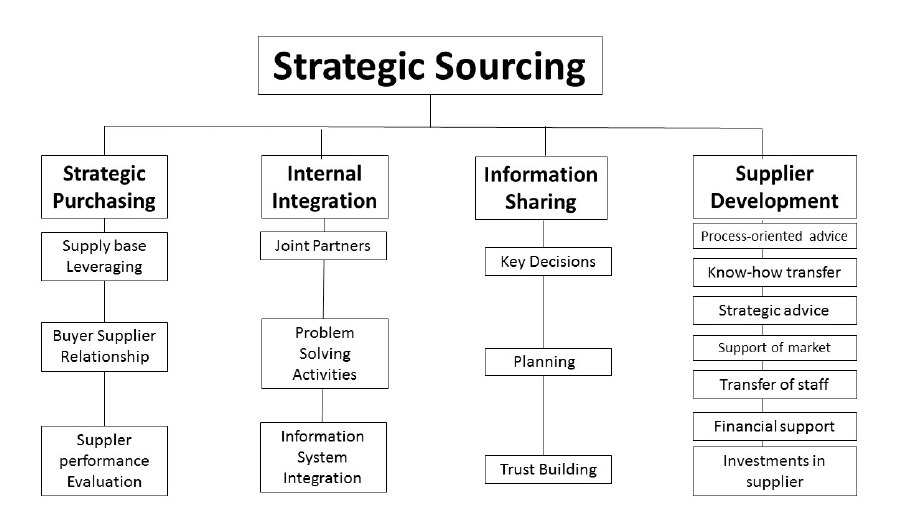
Figure 1: Framework for performance measurement system in the strategic sourcing